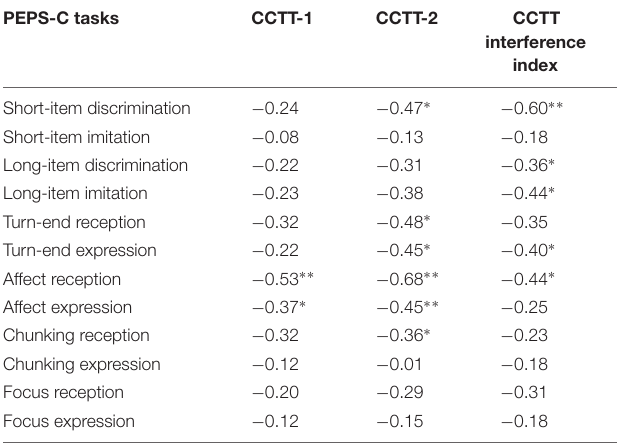
TABLE 3 | Correlations between PEPS-C tasks, CCTT-1, CCTT-2, and CCTT interference index. PEPS-C